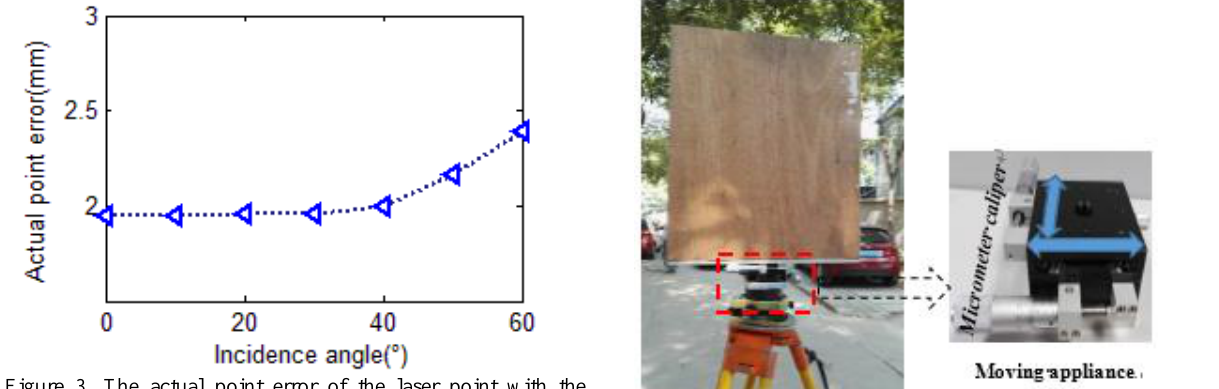
d e f refers to the 0